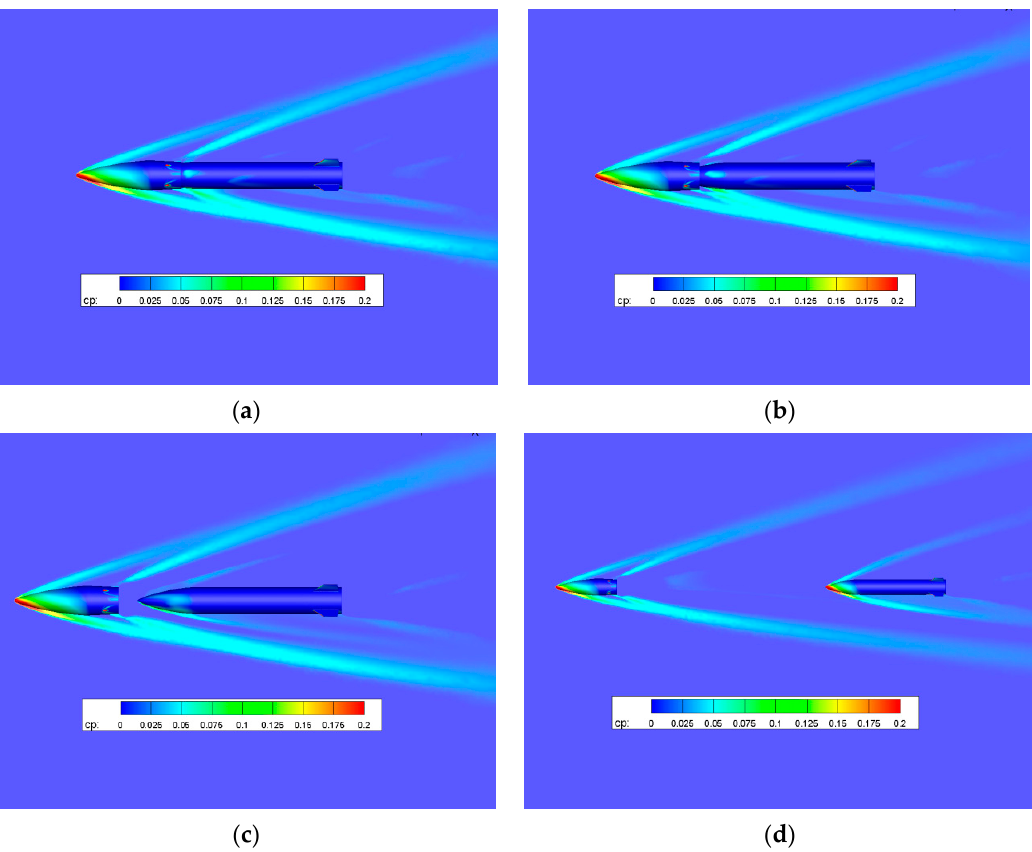
Figure 4. ( a )Pressure contours of the fuselage at 0 ms; ( b ) pressure contours of the fuselage at 80 ms; ( c ) pressure contours of the fuselage at 120 ms; ( d ) pressure contours of the fuselage at 220 ms.